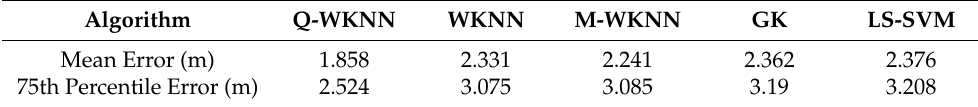
Table 3. P o sitioning errors of different algorithms on Zenodo.